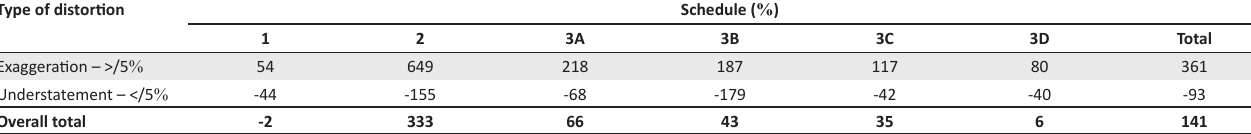
TABLE 7: Average graph discrepancy index per schedule. Type of